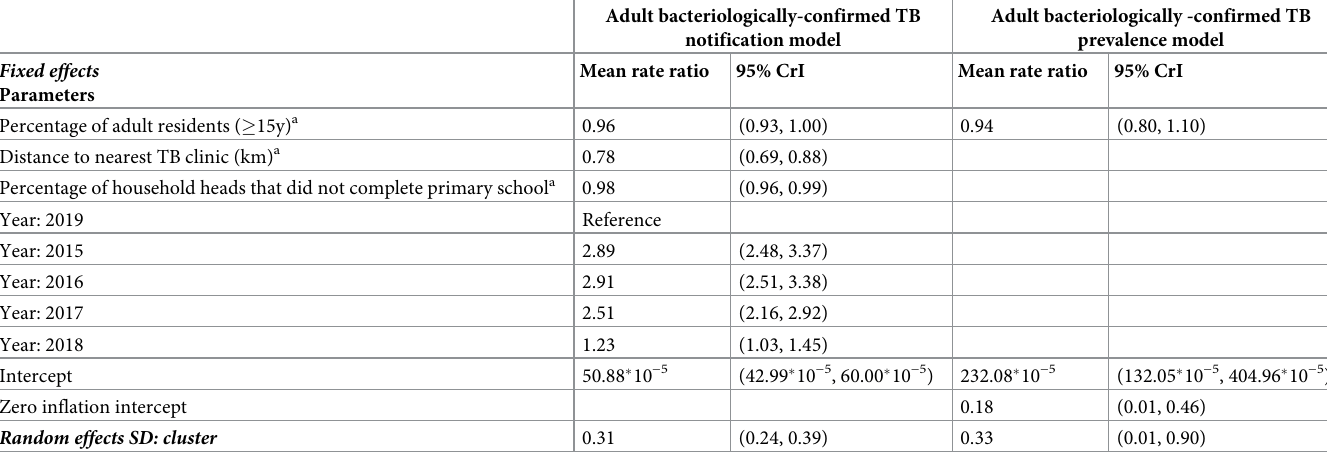
Table 2. Parameter estimates for selected regression models for predicting neighbourhood level TB prevalence and